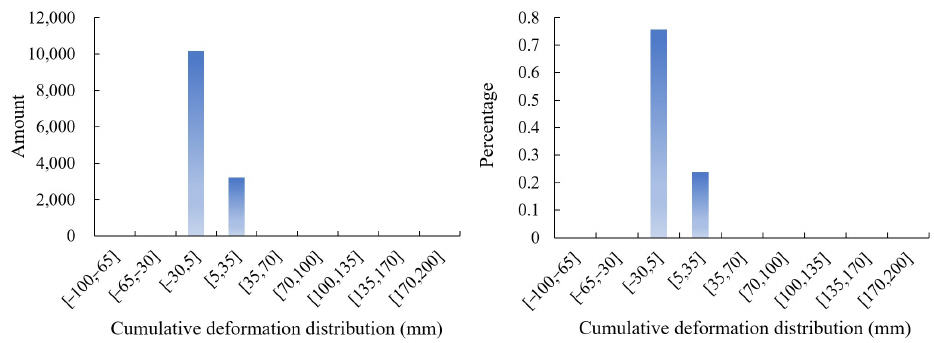
Figure 10. Histogram of cumulative deformation range (Unit: mm).